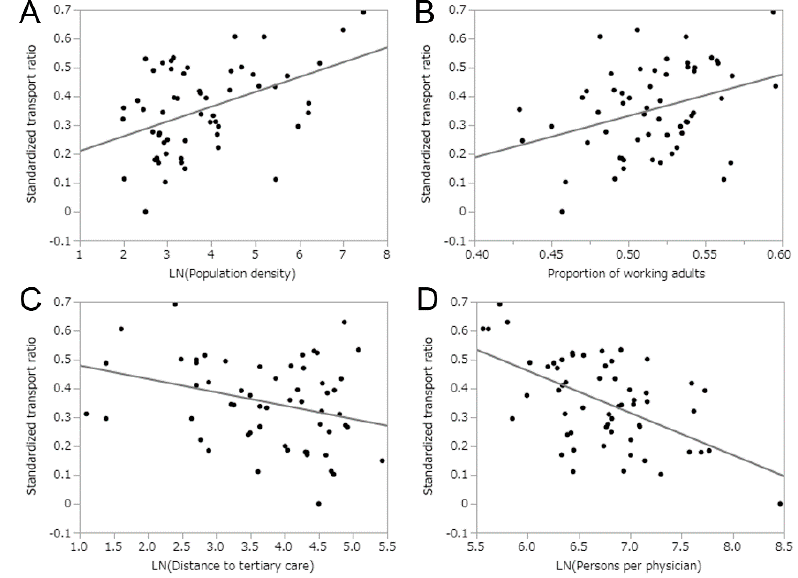
Figure 4. Univariate relationships between the standardized transport ratio for mild psychiatric diseases upon arrival and socioeconomic characteristics. Scatter plots show the correlations between two variables. Horizontal axes are ( A ) population density, ( B ) proportion of working-age adults in the population, ( C ) distance to the nearest tertiary care hospital, and ( D ) population per physician. Lines represent the best-fit prediction based on univariate linear correlation analysis. It should be noted that logarithmic scaling was used for the vertical axes and also the horizontal axes of A, C, and D.